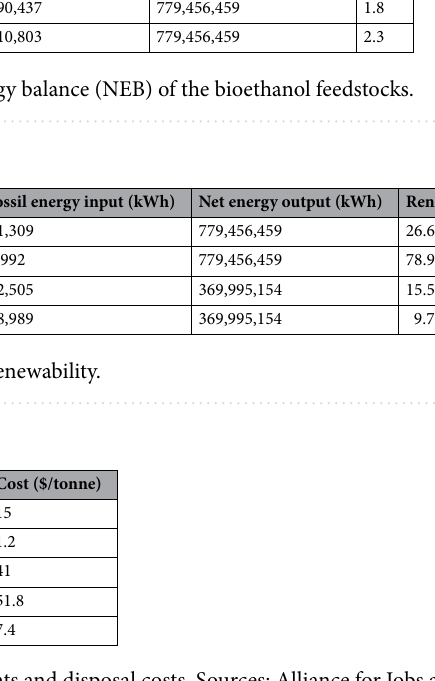
Table 10. Pollutants and disposal costs. Sources: Alliance for Jobs and Clean Energy 43,44 .